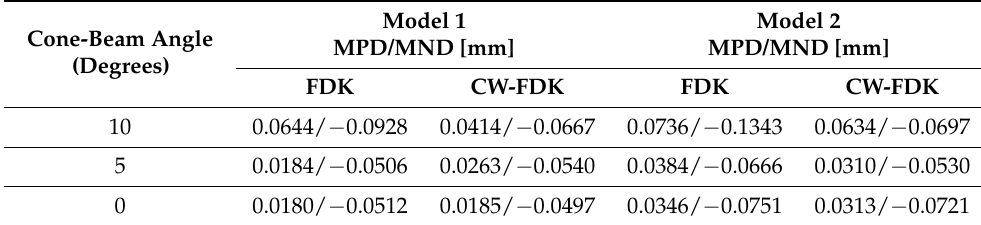
Table 1. The mean of positive deviations (MPD) and the mean of negative deviations (MND) in the 3D